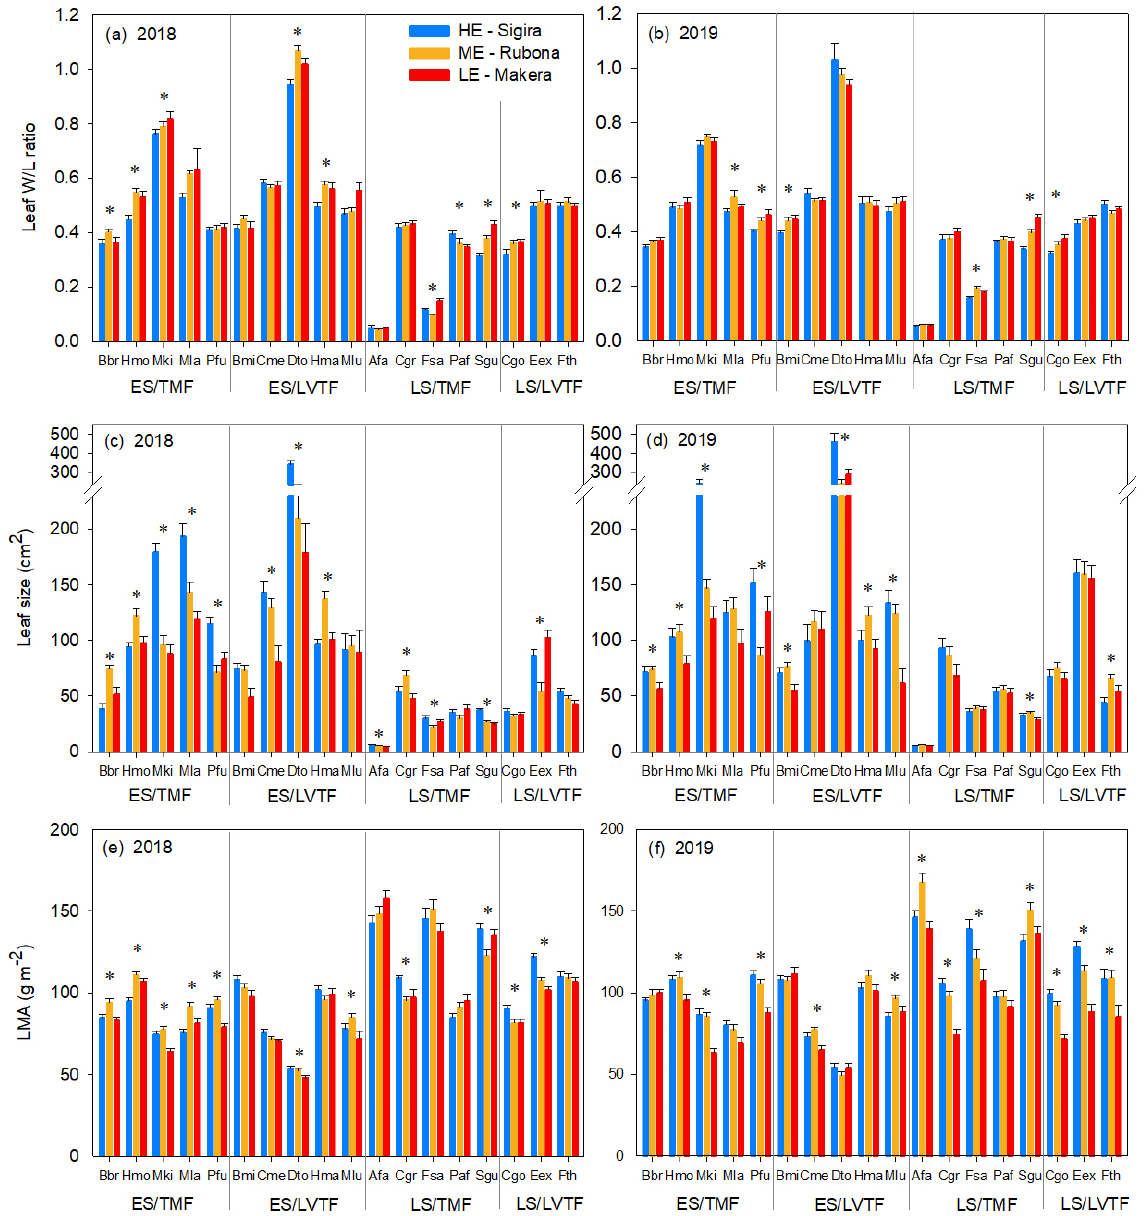
Figure 4. ( a – f ) Site (i.e., warming) effect on ( a , b ) leaf width-to-length ratio (W/L), ( c , d ) leaf size and ( e , f ) leaf mass per area unit (LMA) in 18 species (see Table 1 for full names) measured at three sites of different elevation (HE, ME and LE, high, mid and low elevations, respectively) in ( a , c , e ) 2018 and ( b , d , f ) 2019. The species are divided into four groups, depending on successional stage and forest type of origin. ES and LS, early and late successional, TMF, tropical montane forest and LVTF, Lake Victoria transitional forest. * indicate statistical differences between sites within species ( p < 0.05); see Table 3 for detailed statistical results. Note the broken axis for leaf size.